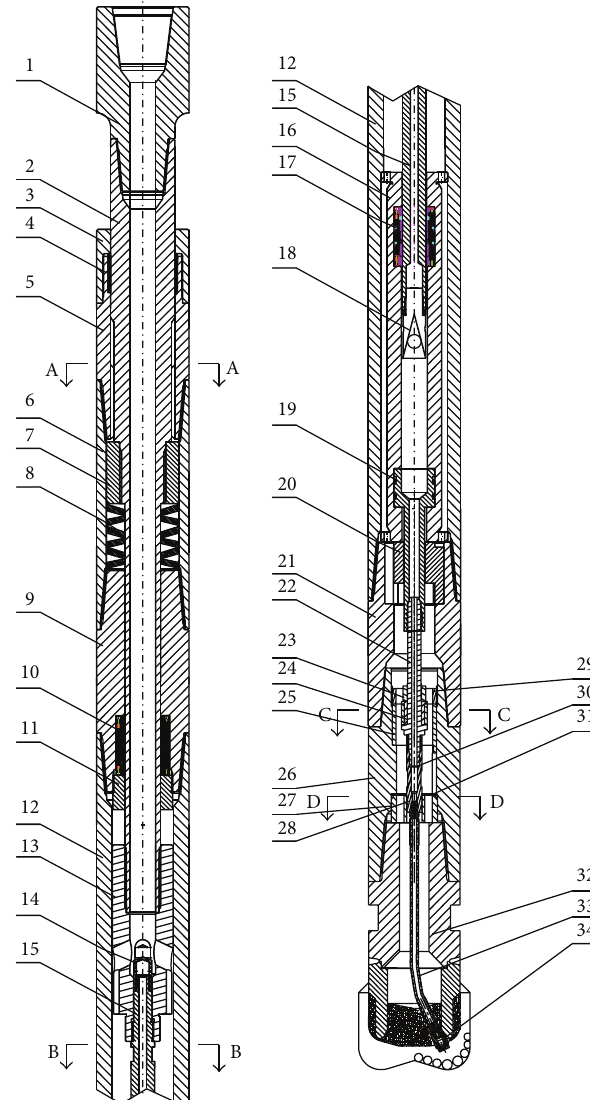
Figure 2: Structure of the downhole drill string shock-absorption and hydraulic supercharging device. Upper X-over 1; splined mandrel 2; sealingset3;springchamberuppersealassembly4;splinedouterbarrel5;springprotectivebarrel6;splinedchecknut7;spring8;springlower joint9;springchamberlowersealassembly10;lowersealingset11;superchargingassemblyouterbarrel12;shuntpressurejoint13;drillingfluid filter 14; plunger 15; supercharging cylinder 16; hyperpressure seal assembly 17; inlet nonreturn valve 18; high-pressure runner 19; supported overflow frame 20; supercharger lower joint 21; metal hyperpressure drilling fluid runner 22; check nut 23; hexahedron 24; antitwist overflow structure 25; X-over 26; rigid pipe centralizer 27; hyperpressure drilling fluid runner extension pipe 28; locknut 29; pressure seal 20; adjustable retainer ring 31; drill frame 32; hyperpressure hose 33; hyperpressure frill fluid nozzle